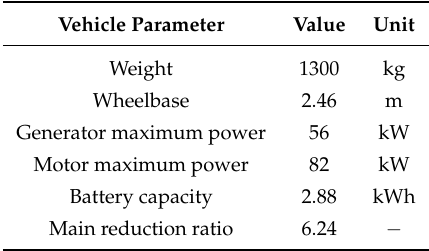
Table 6. Basic parameters of